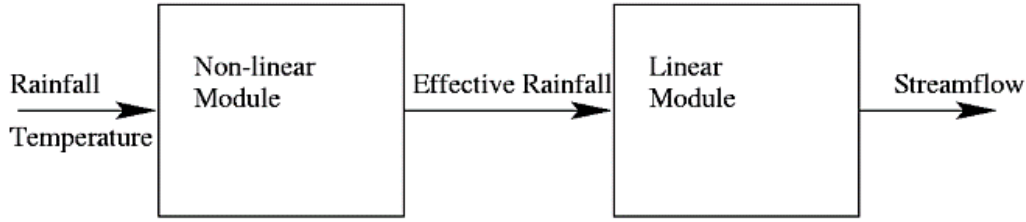
Figure 2. Generic structure of the identification of unit hydrographs and component flows from rainfall, evapotranspiration and streamflow data (IHACRES) model. Retrieved from Croke and Jakeman [1]. The IHACRES model has six (6) parameters used in runoff simulation with an additional two (2) parameters for ephemeral streams [20,46]: the catchment drying rate at a reference temperature, (cid:2028) (cid:3050) , which